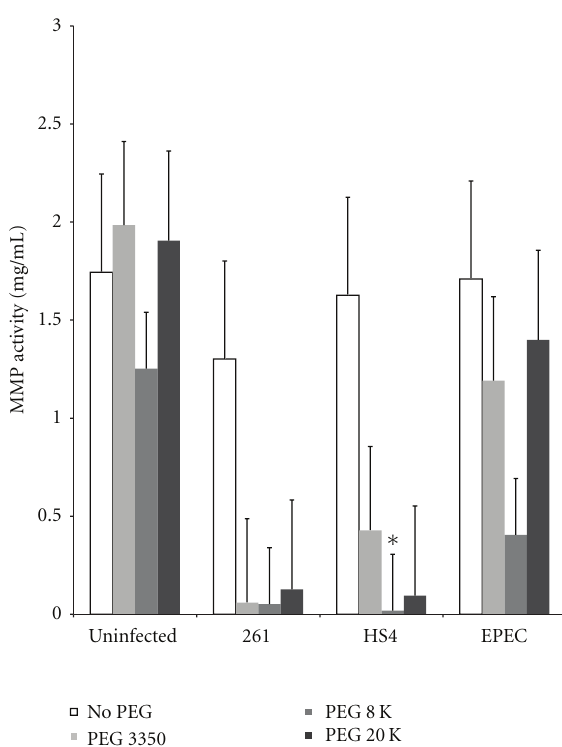
Figure 6: MMP-1 Activity of Caco-2 cells infected with commensal and pathogenic bacteria and treated with 10% PEG. MMP-1 ac- tivity in cells treated with commensal bacterial strains were com- paratively lower than when infected with pathogenic (EPEC). PEG significantly reduced the MMP-1 activity when infected with bac- teria (both commensal and pathogenic). A 12-fold decrease in MMP-1 activity was noted in samples treated with PEG 8000 and infected with commensal bacteria. Standard Student’s t -test was applied to the samples and the P < 0 . 05 were obtained for samples treated with PEG 8000 and HS4 indicated by an asterisk ( ∗ ).